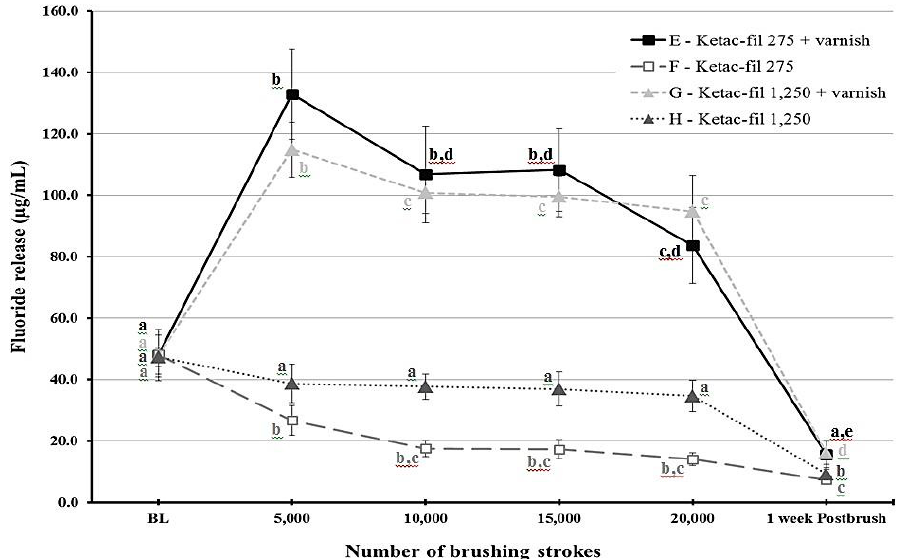
Figure 2. A line graph showing the mean fluoride release from Ketac-fil (KF) material at different time points throughout the study period. Error bars indicate standard deviation. Same letters indicate non-significant differences ( p > 0.05) between values at different brushing levels within the same group.